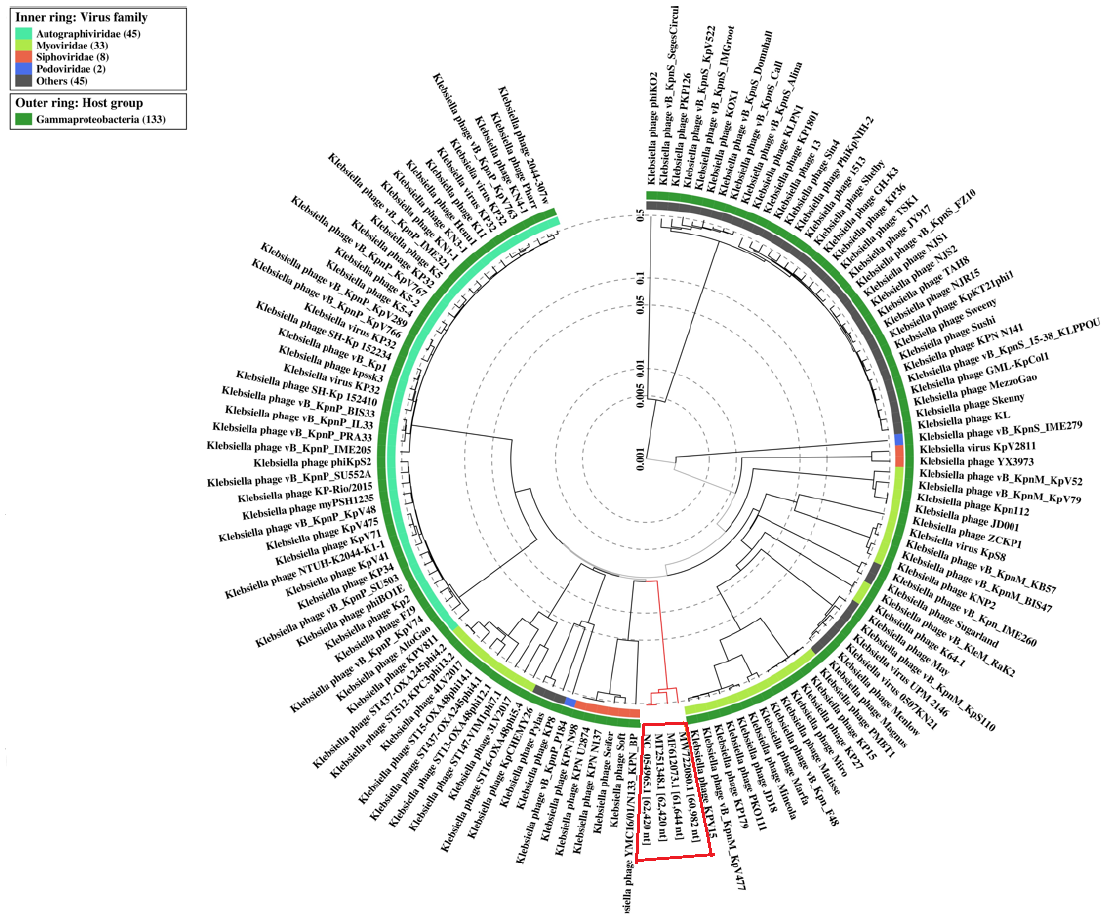
Figure 12. ViPTree Phylogenetic analysis constituted from genome-wide sequence similarities computed by tBLASTx. The circular proteomic tree based on the whole-genome sequences of 137 Klebsiella phages was generated by ViPTree software. LASTA and SJM3 phages were clustered in a discrete group with only two other phages — SopranoGao (accession number MF612073.1) and vB_KpnP_ZX1 (accession number MW722080.1) — classified in the genus Lastavirus.